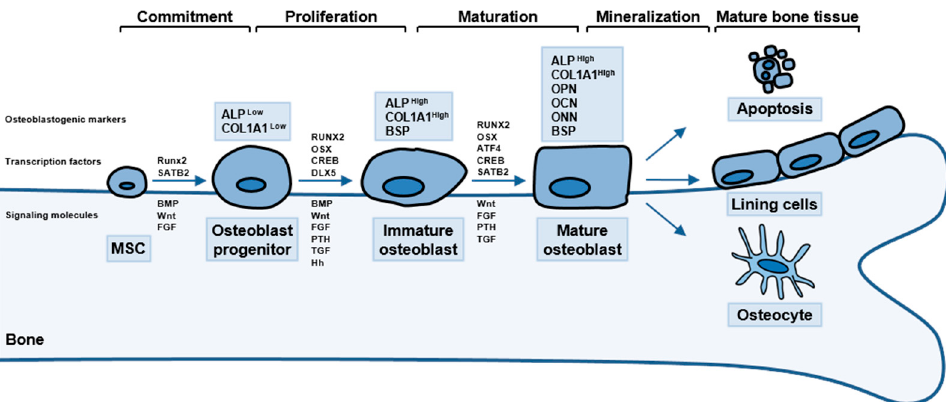
Figure 1. Schematic representation of osteoblast (OB) differentiation. MSC, mesenchymal stem cell. BMP, bone morphogenetic protein. FGF, fibroblast growth factor. RUNX2, runt-related transcription factor 2. PTH, parathyroid hormone. TGF, transforming growth factor. Hh, hedgehog. SATB2, special AT-rich sequence-binding protein 2. OSX, osterix. ATF4, activating transcription factor 4. CREB, cAMP-responsive element-binding. ALP, alkaline phosphatase. OPN, osteopontin. OCN, osteocalcin. ONN, osteonectin. BSP, bone sialoprotein. COL1A1, collagen type 1 alpha 1 chain.